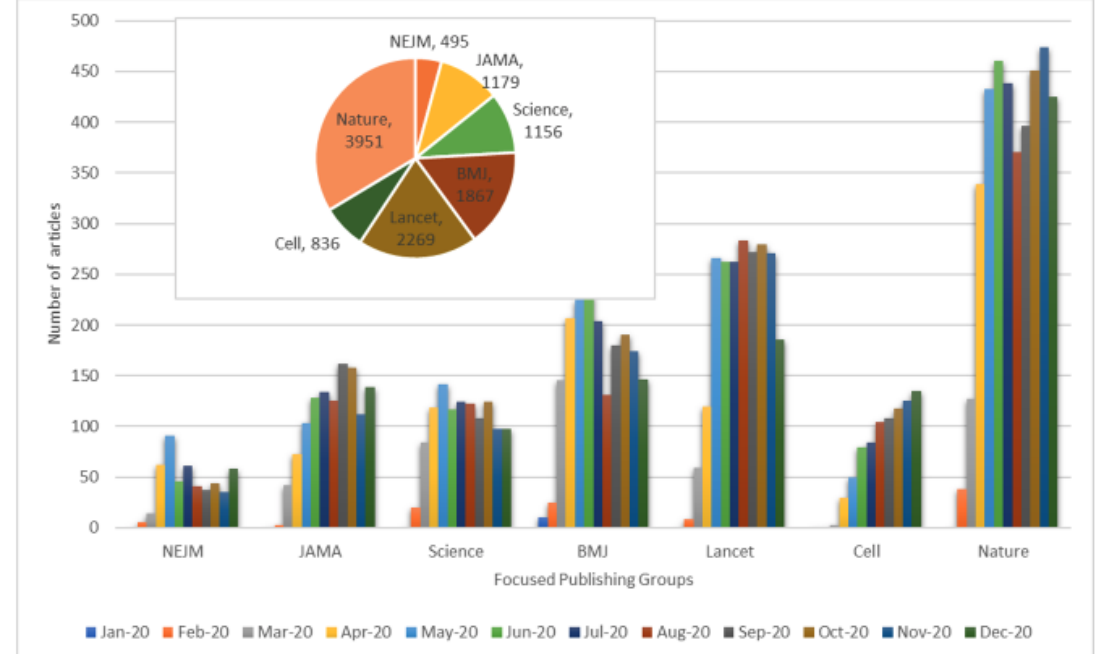
Figure 3. Monthly progression of publications on COVID-19 according to publisher. NEJM: New England Journal of Medicine, JAMA: Journal of the American Medical